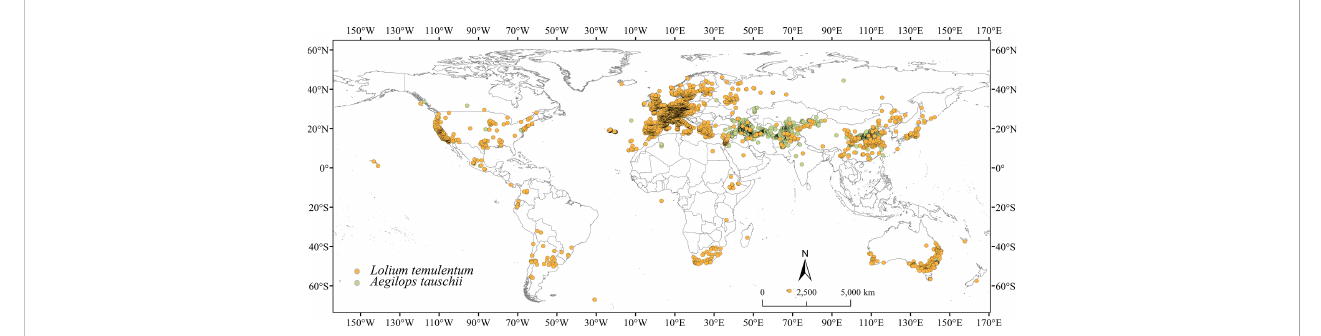
FIGURE 1 Occurrence records of Lolium temulentum and Aegilops tauschii